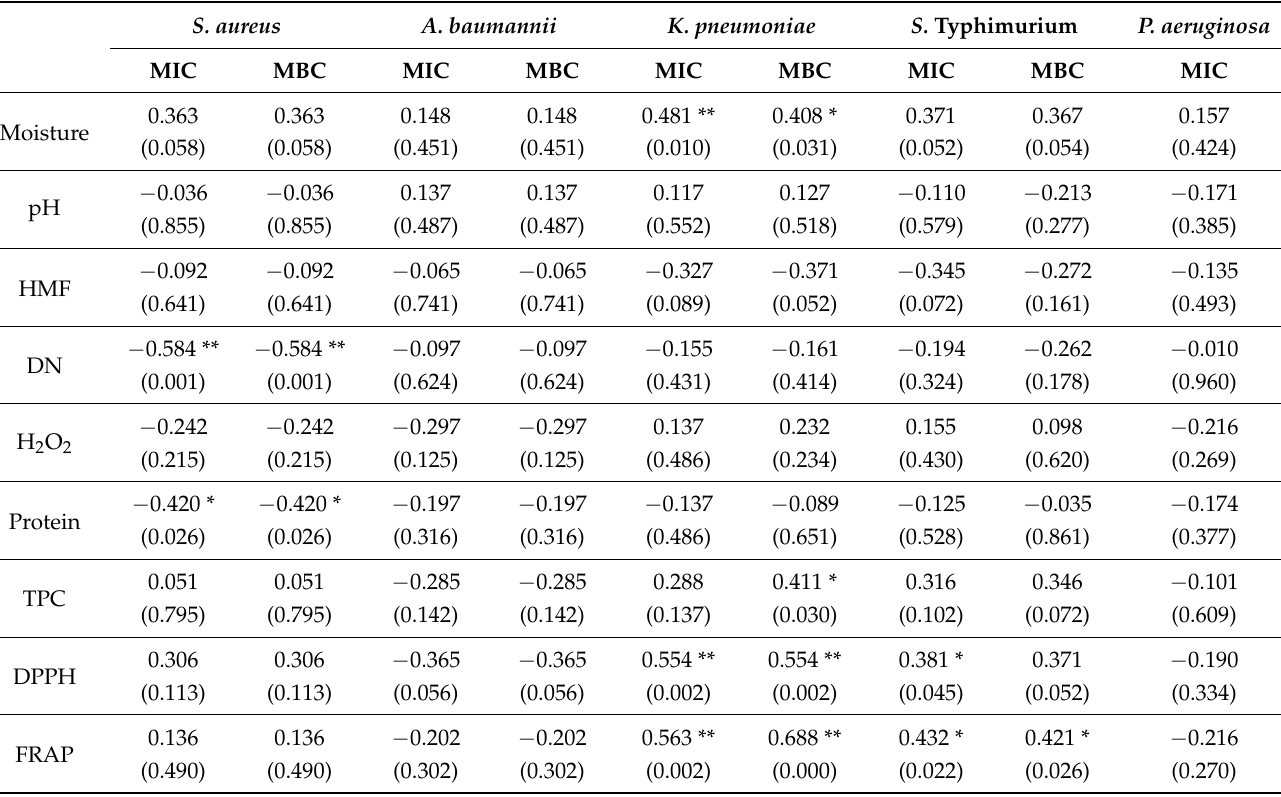
Table 3. Correlation coefficient (r) and significance (parenthesis) values calculated by Spearman’s correlation